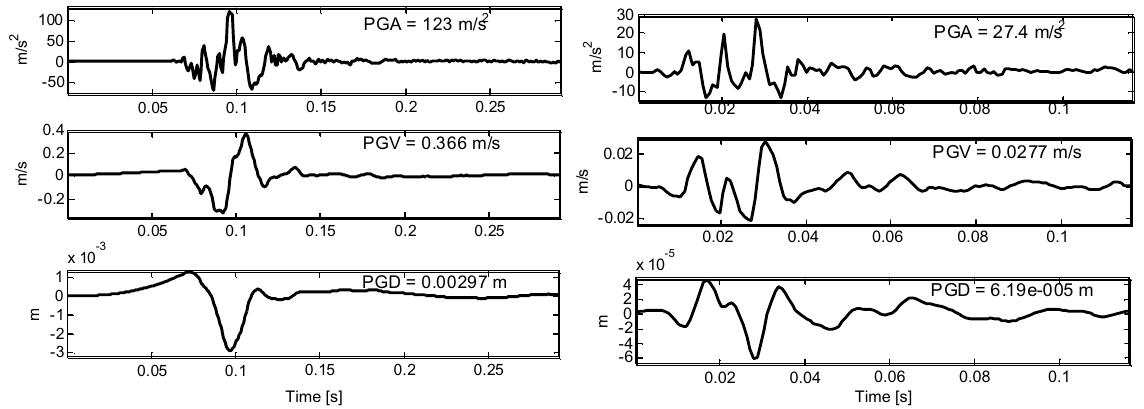
Fig. 2. (Left) An example of a strong ground motion. Seismic event with magnitude 2 is located 90 m from strong ground motion sensor. Horizontal component of the accelerogram is converted to velocity and displacement with PGA = 123 m/s 2 , PGV = 0.366 m/s and PGD = 0.00297 m. (Right) An example of a weak ground motion with PGA = 27.4m/s 2 , PGV = 0.0277 m/s and PGD = 0.000062